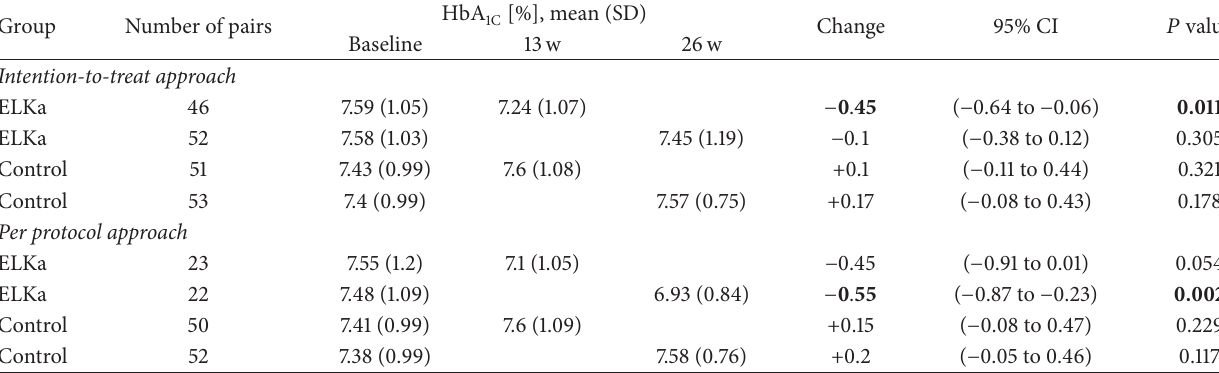
Table 4: Intragroup change in HbA